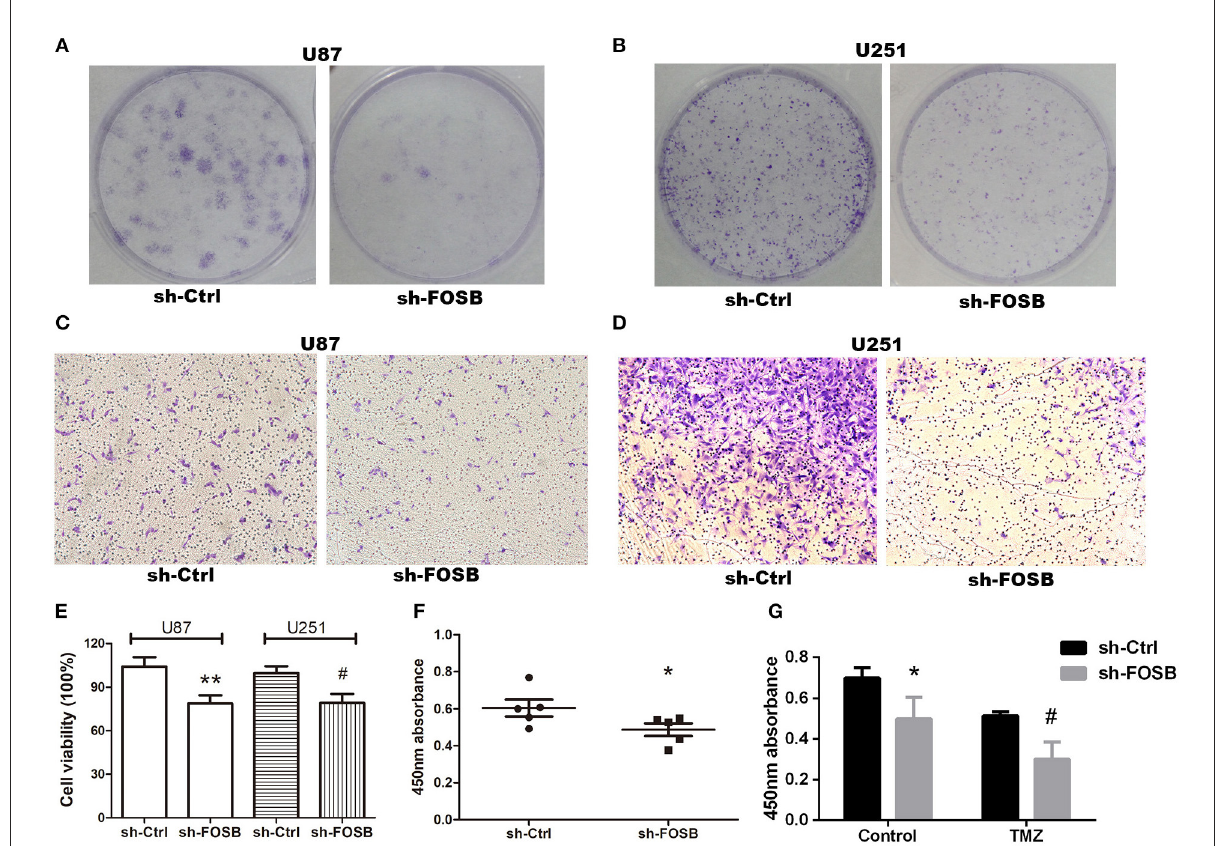
FIGURE3 Effects of FOSB on glioma phenotypes. (A,B) The proliferative ability of U87 and U251 cell lines was detected by plate cloning. (C,D) The invasive ability of U87 and U251 cell lines after downregulation of FOSB was studied by Transwell assay. (E) MTT assay showed that the cell viability of U87 and U251 cells after FOSB knockout decreased. (** P < 0.05 vs. sh-Ctrl of U87 cell lines, # P < 0.05 vs. sh-Ctrl of U251 cell lines). (F) CCK-8 assay was used to detect the proliferation rate of U87 cell lines after the knockdown of FOSB. (* P < 0.05 vs. sh-Ctrl of U87 cell lines). (G) U87 cell lines with knocked down FOSB were treated with TMZ, and cell proliferation was detected 72h after treatment to detect the response of stabilized transfected cell lines to antineoplastic drugs. The control reagent was DMSO, which was the solvent of TMZ ( * P < 0.05 vs. sh-Ctrl of the control group (DMSO) U87 cells; # P < 0.05 vs. sh-Ctrl of TMZ group U87